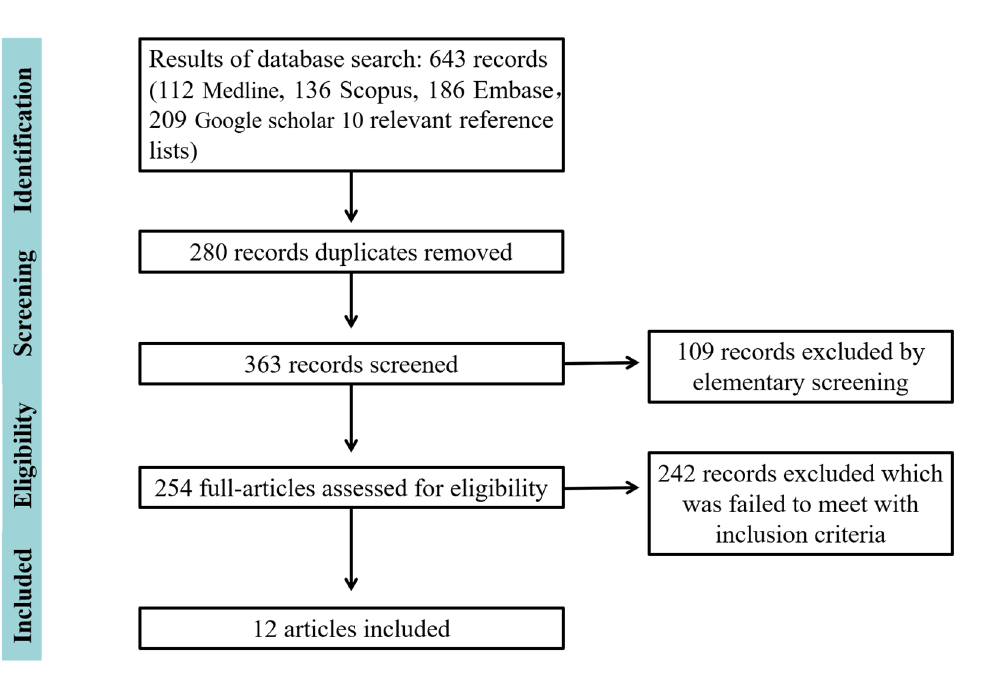
Table 1. Quality assessment of included studies.